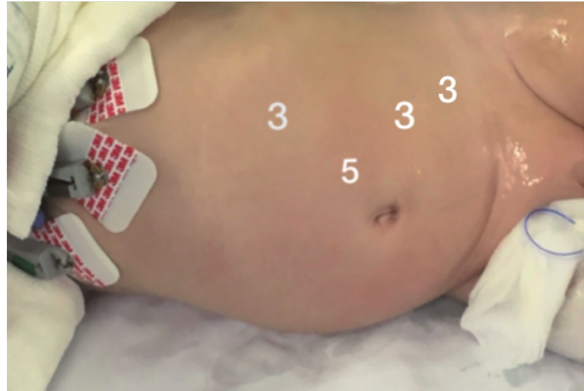
Child postioned to left pyeloplasty in a 60-degree lateral decubitus. One 5mm trocar to the telescope placed lateral to the umbilicus on the side of the affected kidney and two 3mm ports placed in a triangular fashion to the telescope port. The last 3mm port is placed in the lower abdomen on the mid clavicular line. Figure 2 - Trocars position - postoperative period.